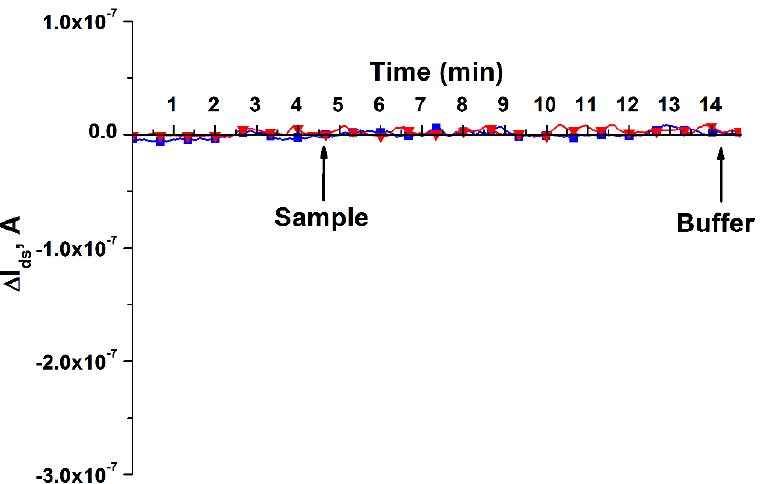
Figure 4. Results of detecting 1 mM PPB and target sDNA in a buffer solution using a nanochip, the surface of which was activated by DTSSP, without covalent immobilization of molecular o-DNA probes. Legend: red curve represents pure 1 mM PPB, no target sDNA; blue curve shows target sDNA with a concentration of C = 1.1 × 10 − 15 M, which is a synthetic analogue of miRNA-17-3p as- sociated with colorectal cancer. The experiment was carried out in a working solution of 1 mM PPB (pH 7,4), V ds = 0.2 V, V g = 50 V; the solution volume in the measuring cell of the biosensor was 450 µL. Arrows indicate the moments of adding 1 mM PPB solutions or target sDNA (Sample), as well as washing potassium phosphate buffer (Buffer).